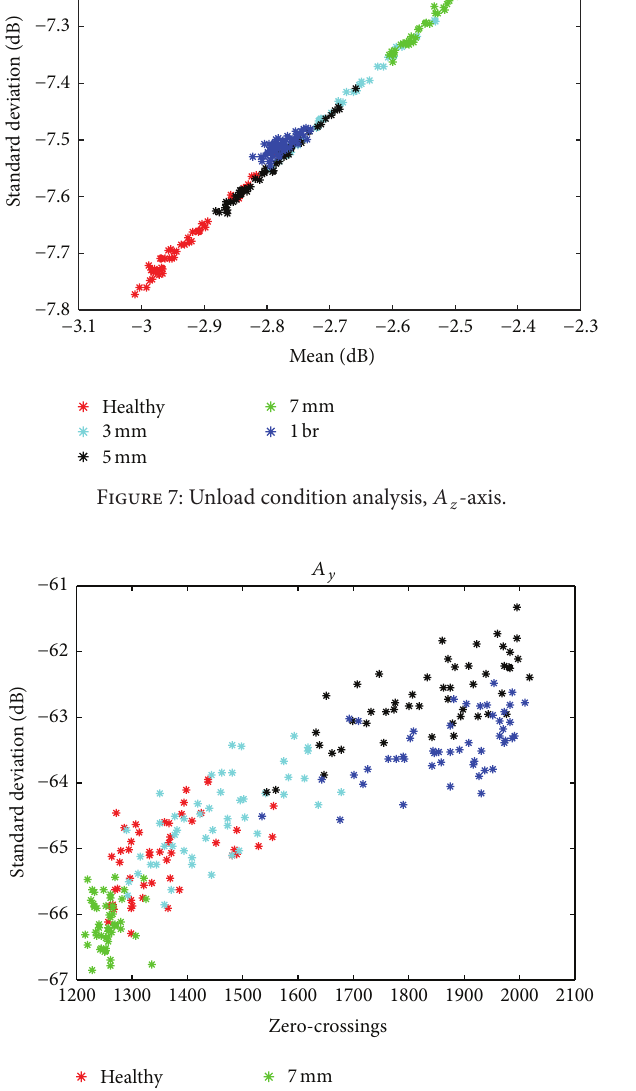
of overlapping is too low showing that the analysis in the 𝐴 𝑥 - axis is the best option to obtain a clear classification of the damage level under a nonmechanical load condition.